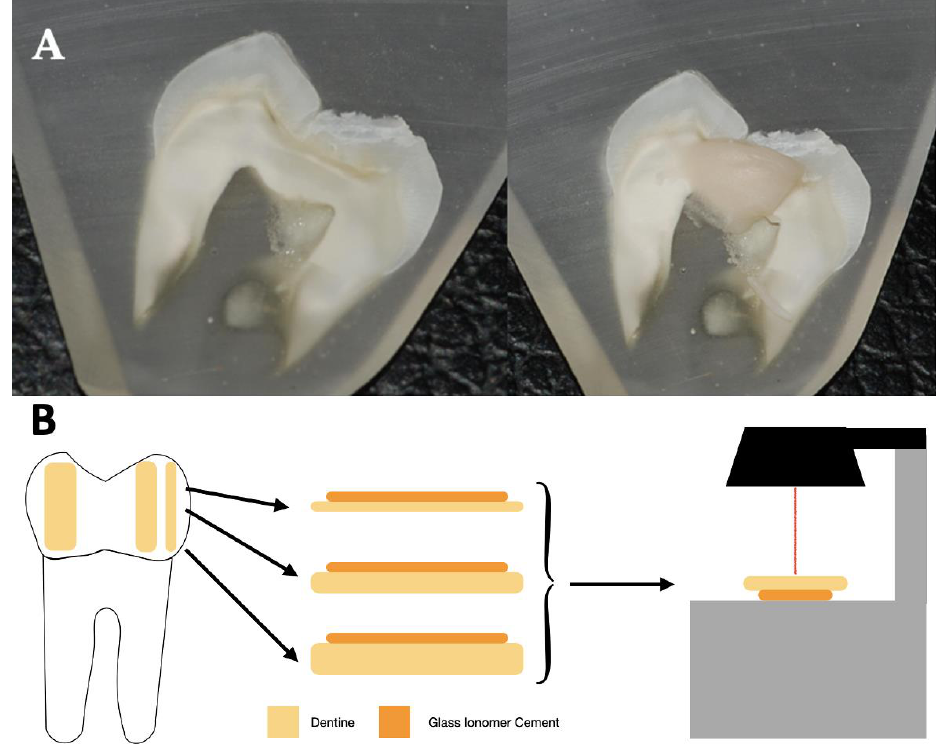
Figure 2. ( A ) Sample before and after the application of the GIC. ( B ) Schematic illustration of the sample preparation and analysis.